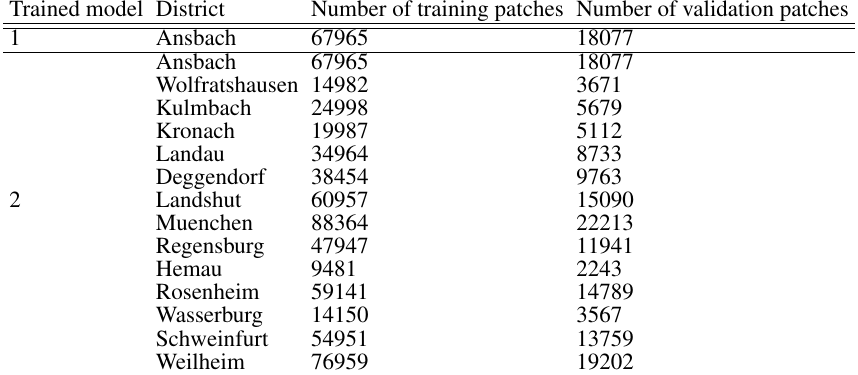
Table 1. The numbers of training and validation patches of the dataset for two different trained models. Trained model